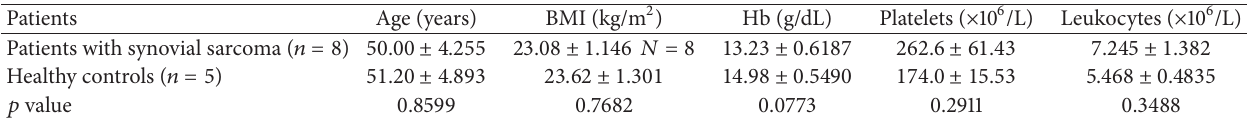
Table 4: Demographic patient data (age, body mass index (BMI), and blood count (Hb: hemoglobin level, platelet count, and leukocyte